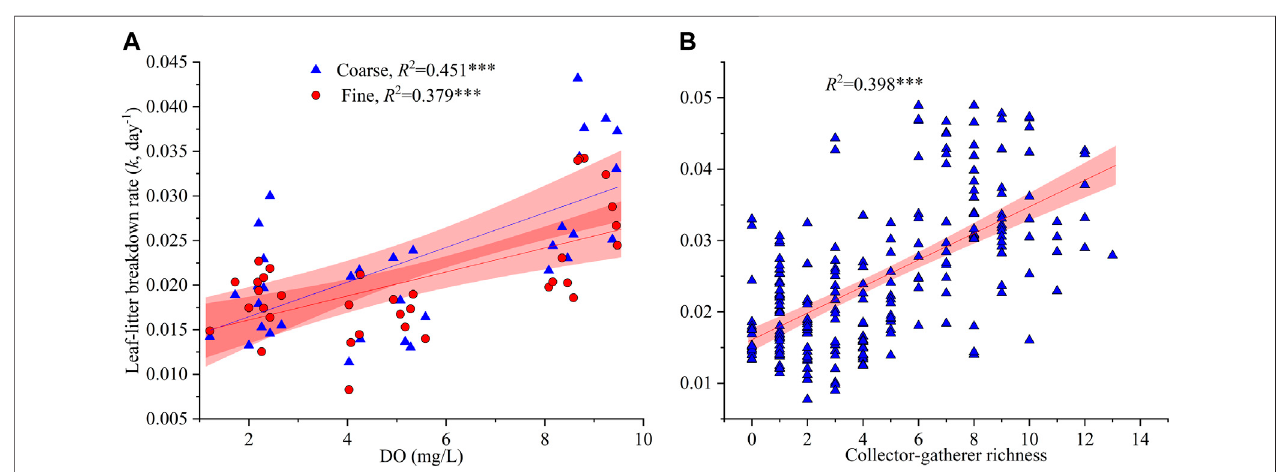
FIGURE 3 | Variations in leaf-litter breakdown rate in relation to dissolved oxygen (A) and collector-gatherer richness (B) . * p < 0.05, ** p < 0.01, *** p < 0.001.